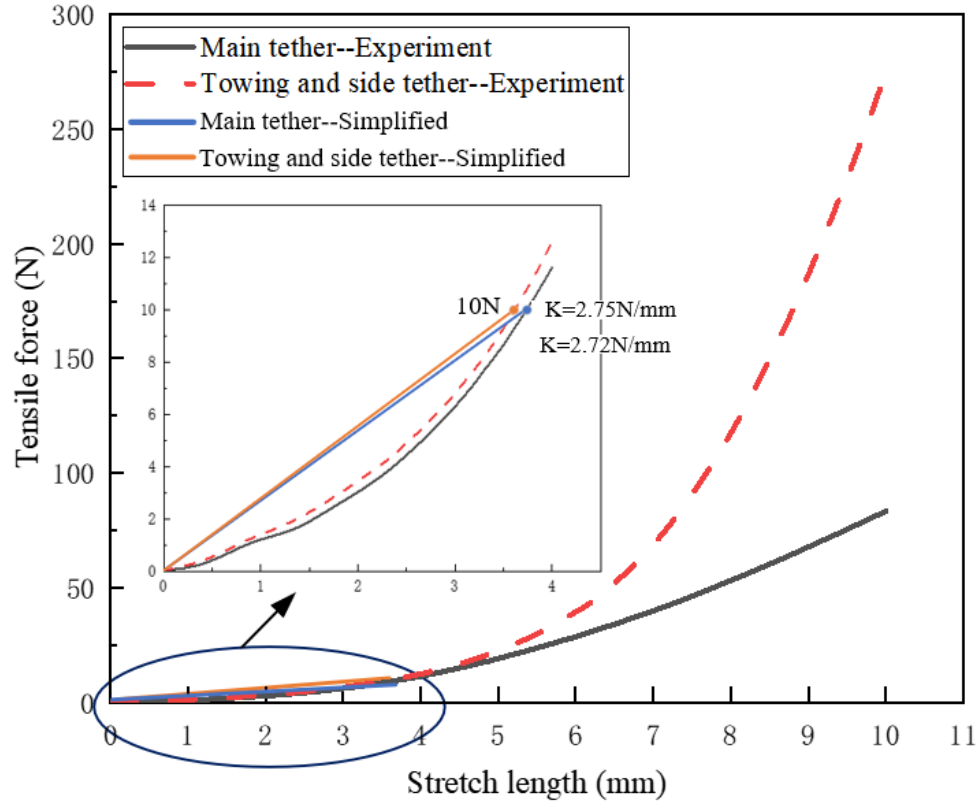
Figure 7. Results of tensile stiffness test of net tethers.